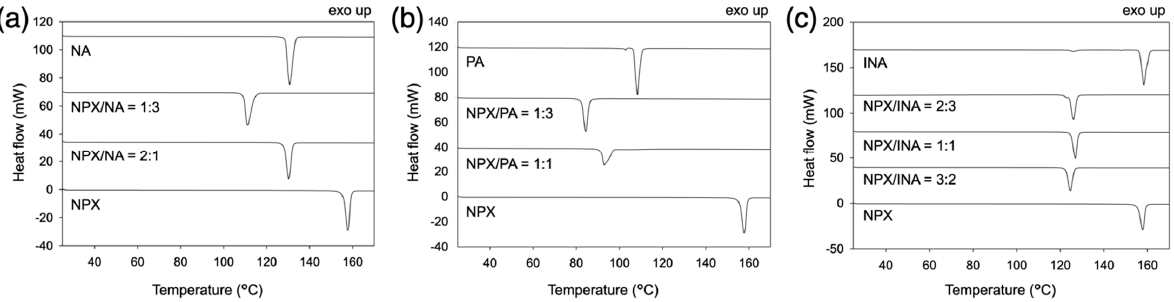
Figure 3. DSC thermograms of some mixtures of ( a ) NPX/NA, ( b ) NPX/PA, and ( c )